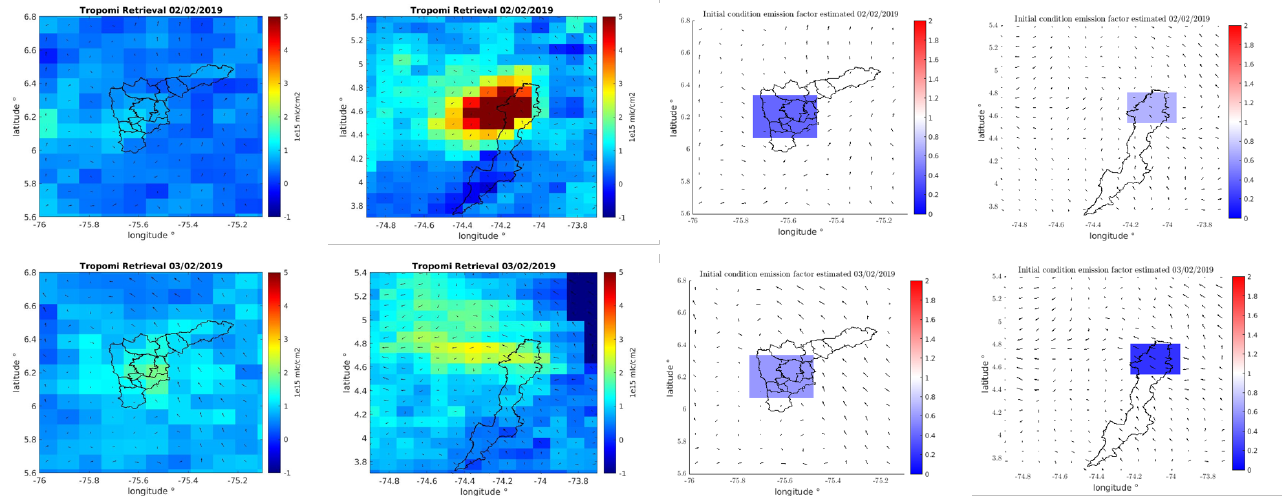
Figure 10. Comparison of the TROPOMI retrieval products for 2 February 2019 and 3 February 2019 with a zoom over the two principal Colombian cities, Medellín and Bogotá. Right panels show the corresponding estimated values of the emission parameters that suggest reduction in the emission for the two cities for the two assimilation